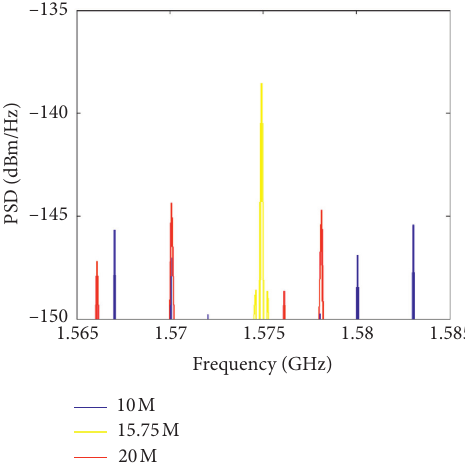
Figure 5: Comparison of power spectral lines of UWB signals under three different